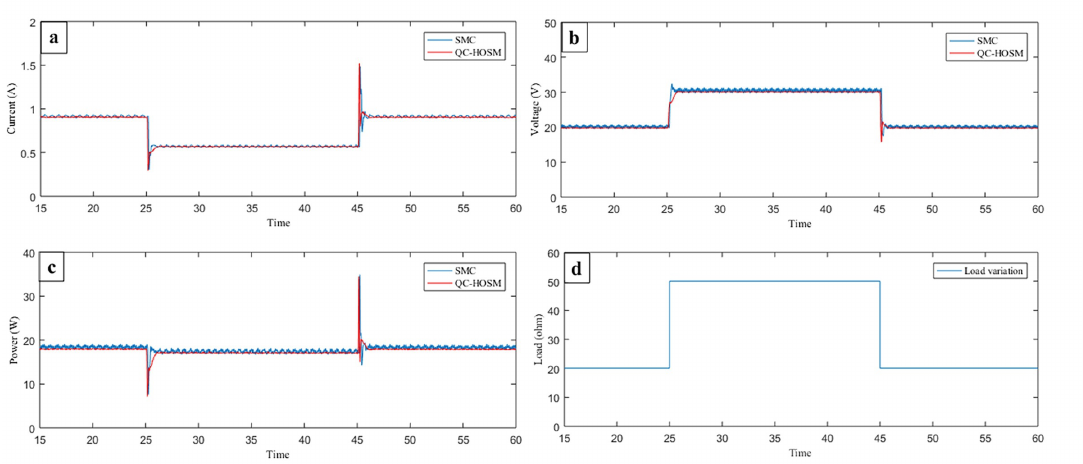
Figure 9. Step-up converter output signals; ( a ) output current; ( b ) output voltage; ( c ) output voltage; ( d ) load